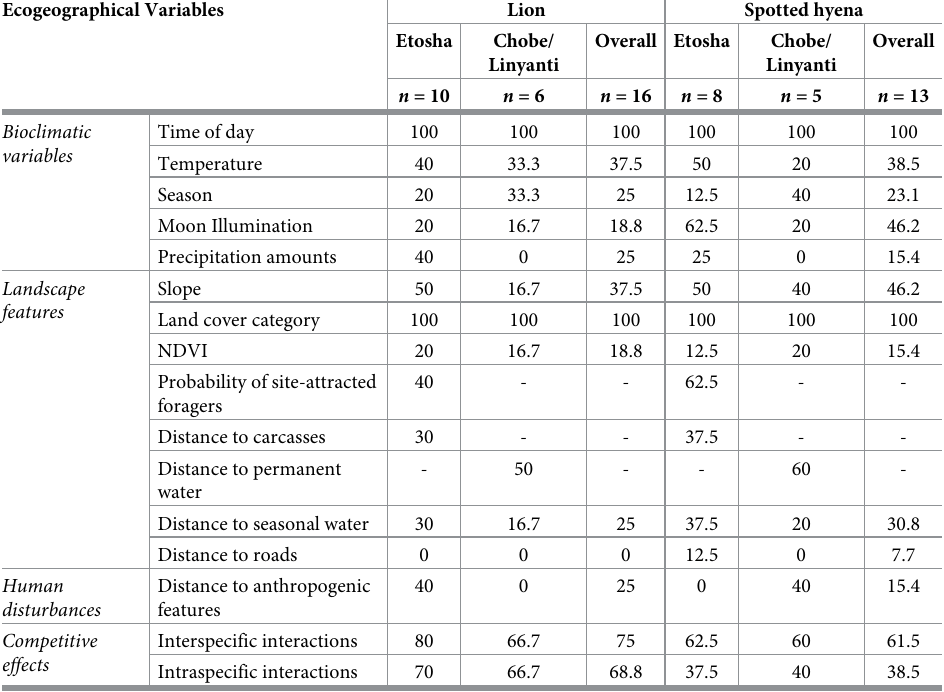
Table 9. Highest-scoring ecogeographical variables for lions and spotted hyenas. Ecogeographical Variables Lion